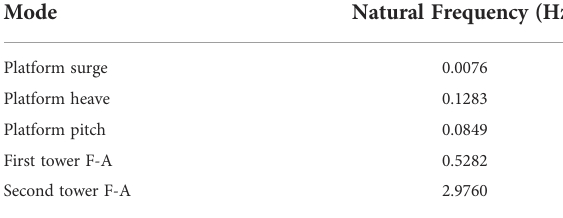
TABLE 2 Natural frequencies of barge-type FOWT (Jonkman,